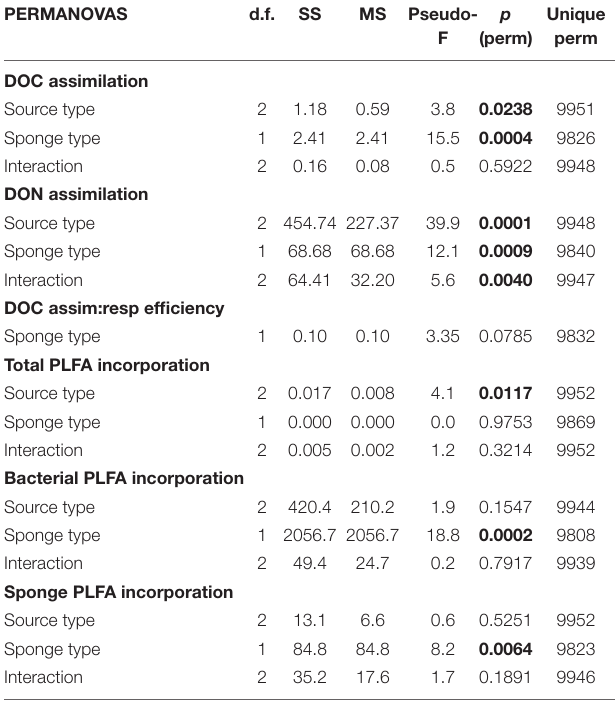
TABLE 3 | Results of individual PERMANOVAs testing for differences in (A) carbon and nitrogen (DOC and DON) assimilation rates into bulk tissue, (B) assimilation-to-respiration efficiencies of diatom-DOM, and (C) carbon assimilation rates into PLFAs (total, sponge-, and bacteria-specific) by tracer DOM source type (macroalgal-, coral-, diatom-DOM), sponge type (LMA and HMA) and their interaction.